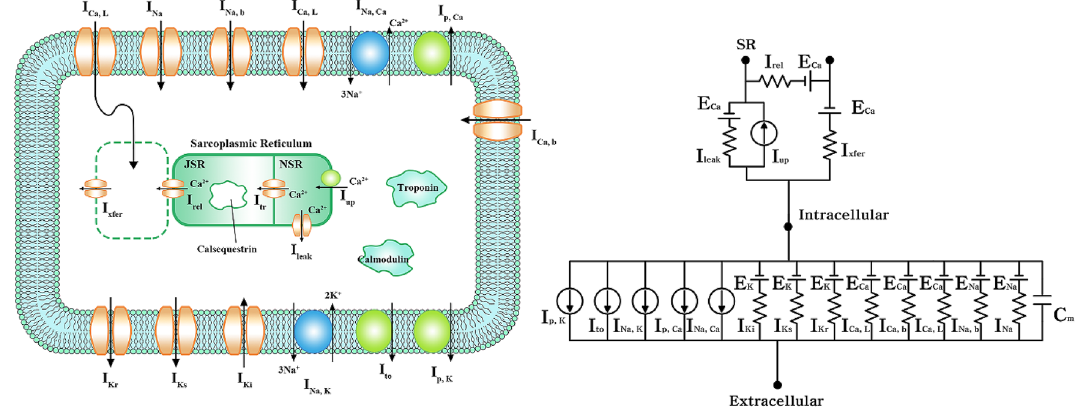
Figure 4. Schematic illustration of the electrophysiological cell model. Electrical schematics representing current, pump, and ion exchanger from Ten Tusscher et al., emulating cell membrane for ion transport and sarcoplasmic reticulum within cardiac cells. “I” represents the ion currents, and “E” the equilibrium potential of each ion; I Na , Na + current; I Ki , inward rectifier K + current; I to , transient outward K + current; I Kr , rapid delayed rectifier K + current; I Ks , slow delayed rectifier K + current; I Ca, L , L-type inward Ca 2+ current; I Na,Ca , Na + – Ca 2+ exchange current; I Na, K , Na + – K + exchange current; I p, K , K + pump current; I p, Ca , Ca 2+ pump current; I Ca, b , background Ca 2+ current; I Na, b , background Na + current; E K , equilibrium potential of K + ; E Ca , equilibrium potential of Ca 2+ ; E Na , equilibrium potential of Na + ; I leak , leakage Ca 2+ current of junctional sarcoplasmic reticulum (JSR); I rel , released Ca 2+ current from JSR; I up , absorbed Ca 2+ current to network sarcoplasmic reticulum (NSR); I xfer , diffusible Ca 2+ current between dyadic subspace and bulk